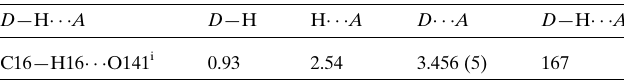
Table 1 Hydrogen-bond geometry (A˚ , (cid:3) ).